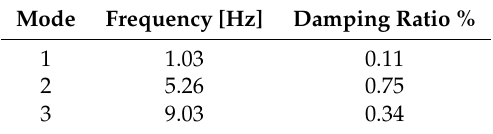
Table 4. Modal parameters of the three-story building-like structure with nonlinear pendulum absorber.